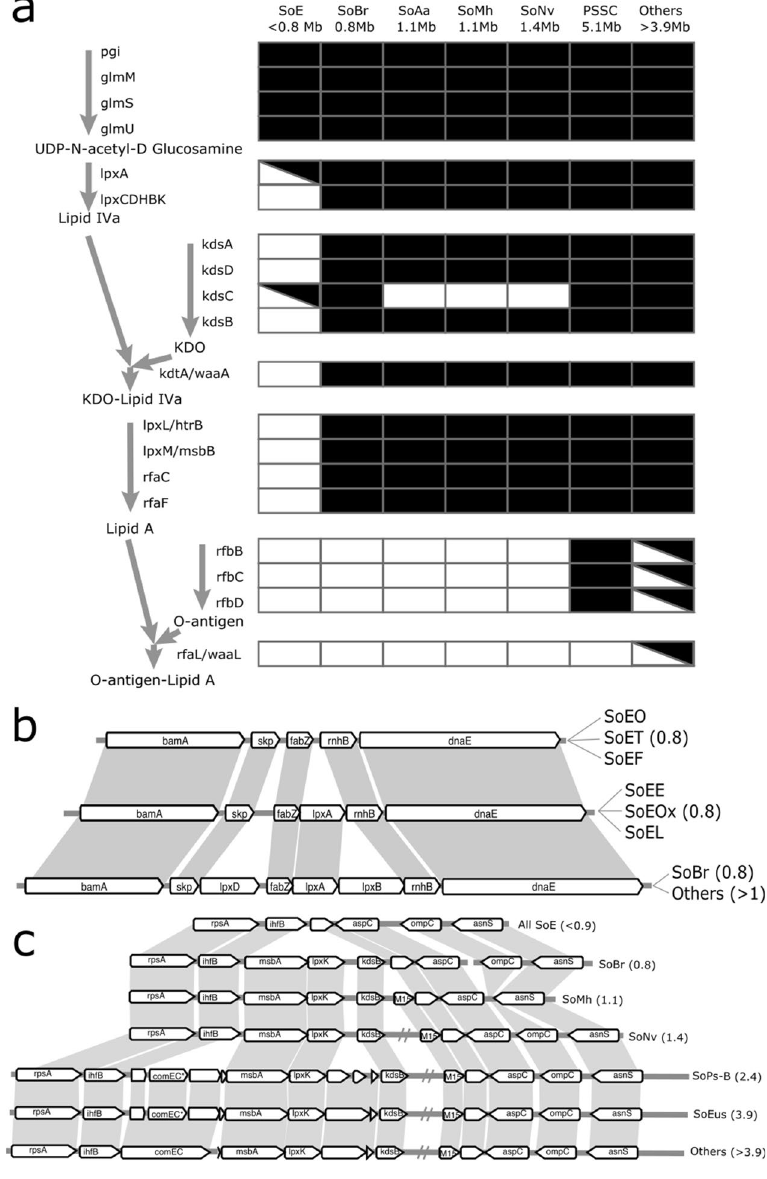
Figure 4. Genes involved in the production of Lipid A and attachment of O-antigen. ( a ) Intermediate metabolites are represented in bold and the presence or absence of a gene is represented in the table, with a crossed box indicating not present in all members. ( b ) Progressive elimination of lpxA, lpxB, and lpxD in the SoE. ( c ) Loss of lpxK kdsB, and adjacent genes. A double grey line indicates a region of approximately 15 kb containing several genes not shown here. Genes labeled ‘hypoth.’ or unlabeled indicate hypothetical proteins or interrupted CDS. Asterisk indicates a fragmented CDS. Numbers in parentheses correspond to genome sizes in